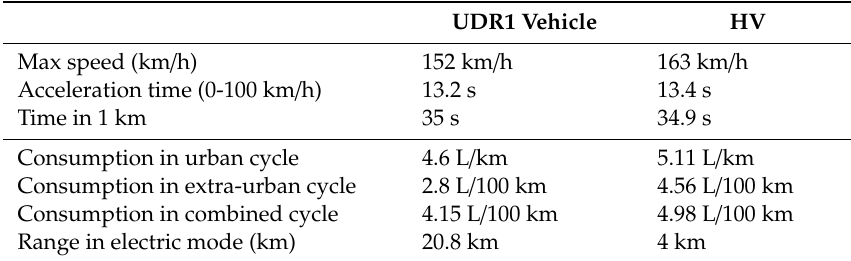
Table 22. Comparison between vehicle and HV.